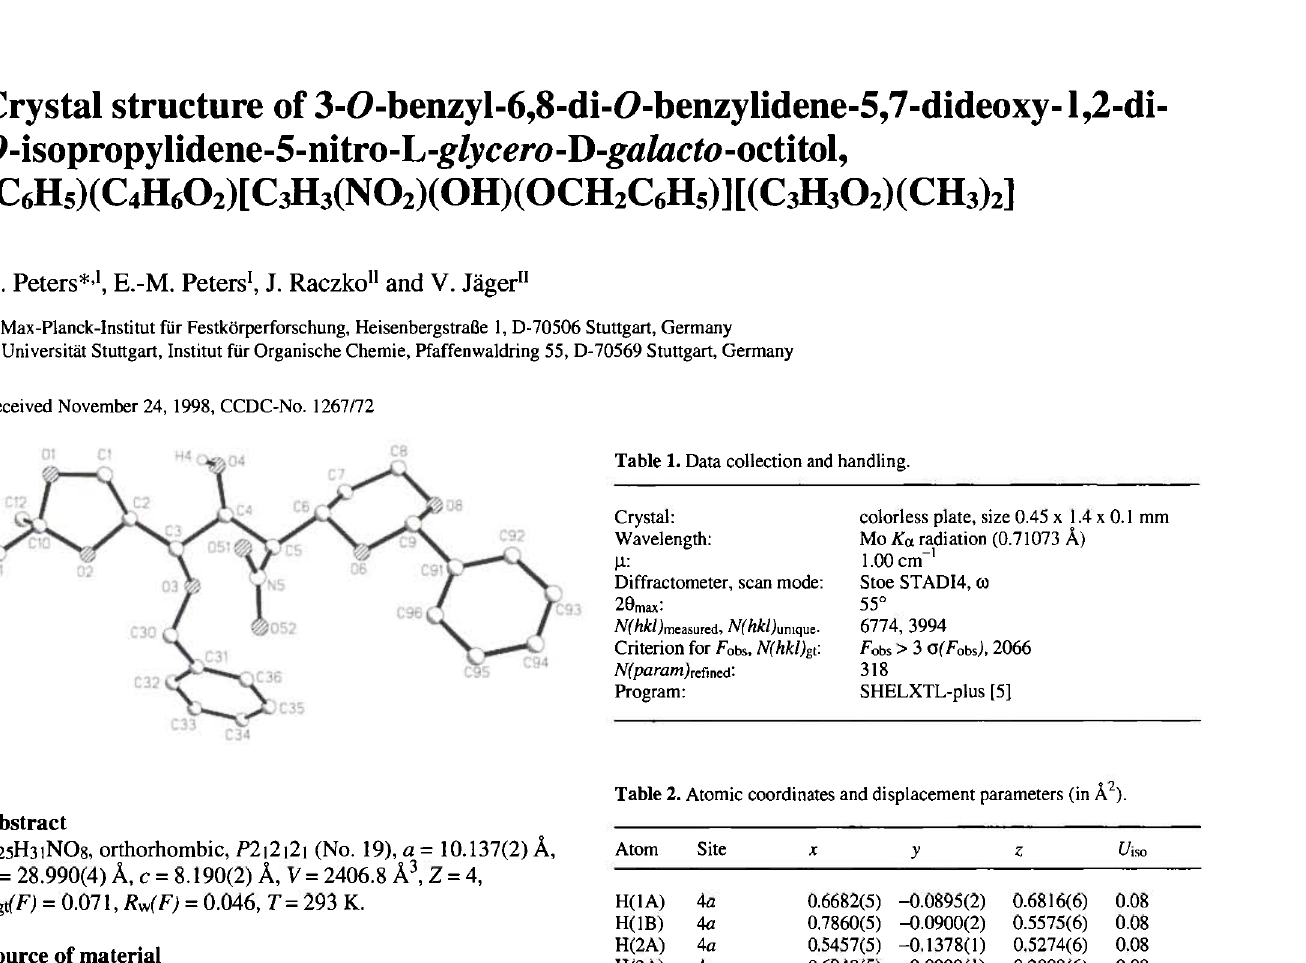
Table 2. Atomic coordinates and displacement parameters (in Ä 2